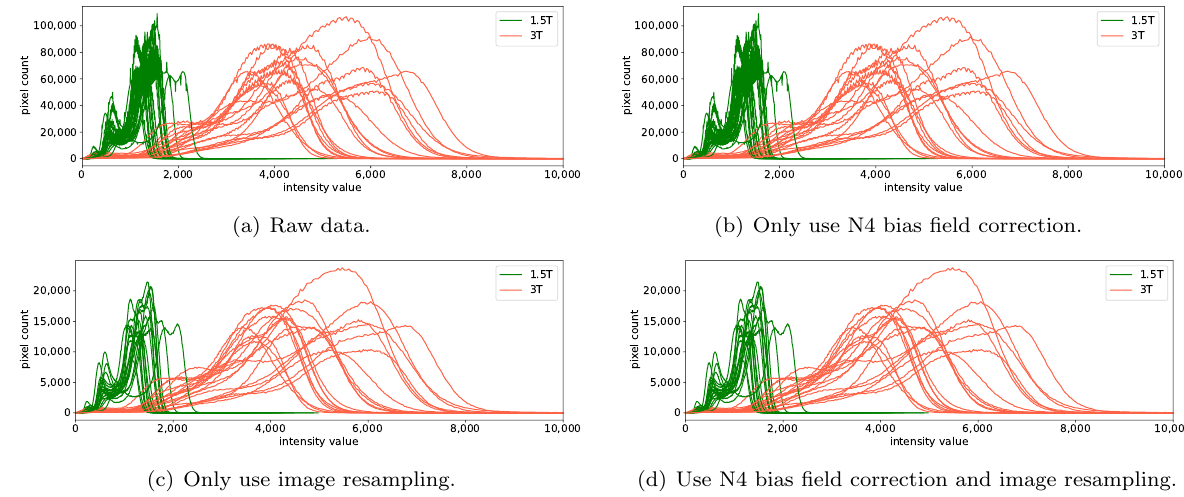
Figure 6. Impact of preprocessing methods on image histograms of brain MRI images of patient data, scanned with 1.5T and 3T. The subfiures show the image histograms of the MRI images ( a ) without using any preprocessing methods (raw data), ( b ) with only using the N4 bias field correction, ( c ) with only using the image resampling (1 mm × 1 mm × 1 mm), and ( d ) with using both the N4 bias field correction and image resampling. Note that the intensity normalization methods and ComBat method were not used